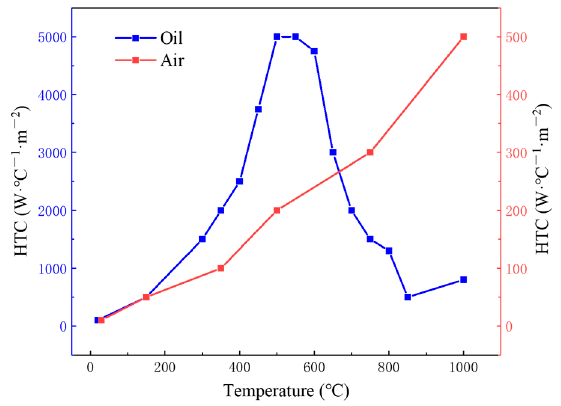
Figure 7. Heat transfer coefficient (HTC) of quenching oil and air